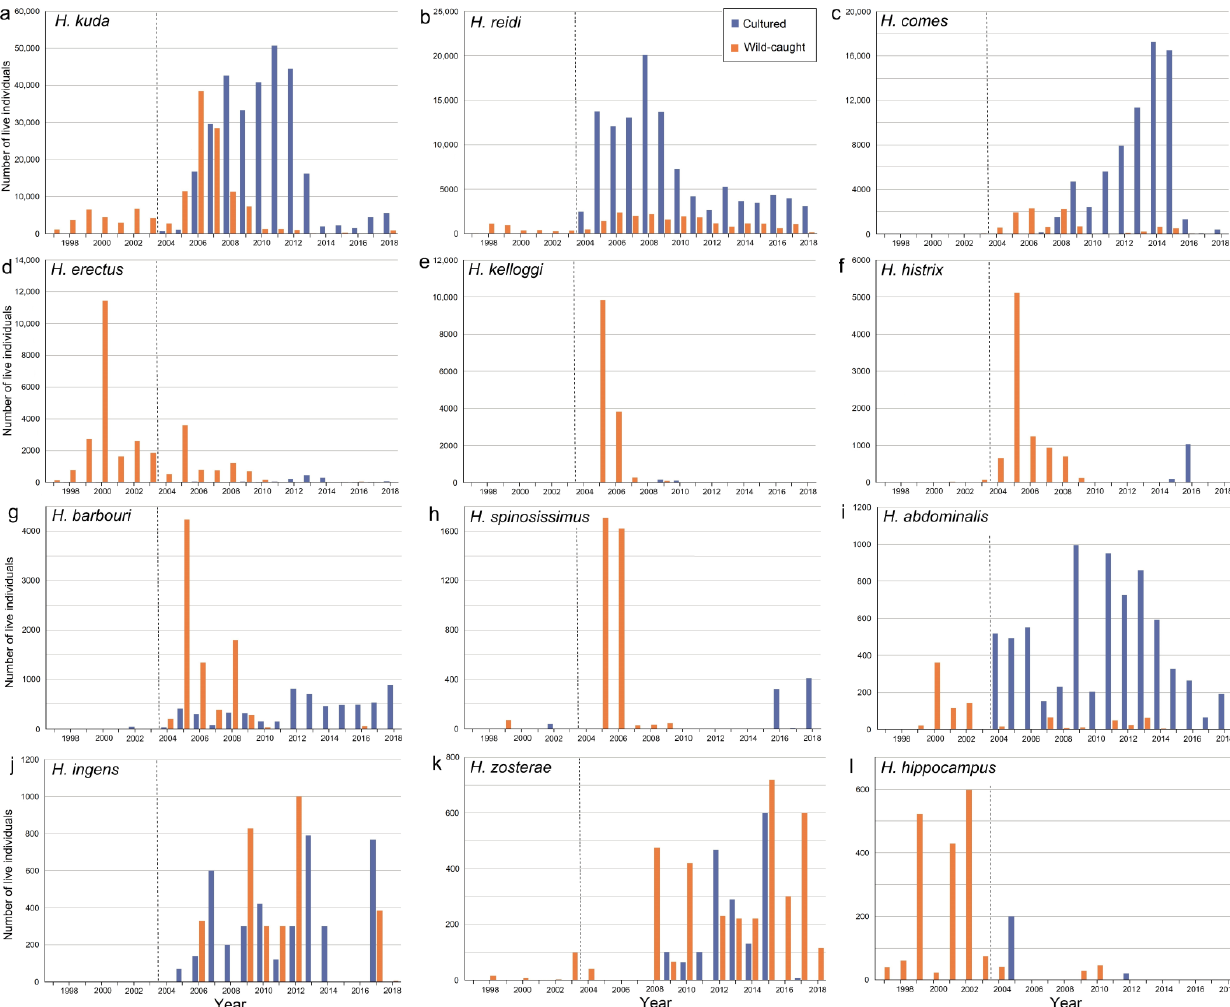
Figure 6. Import data for the 12 most traded Hippocampus species in the period 1997 – 2018 [69]. Data from before 2004 concern the EU only. Cultured = C + F; wild-caught = W + U.